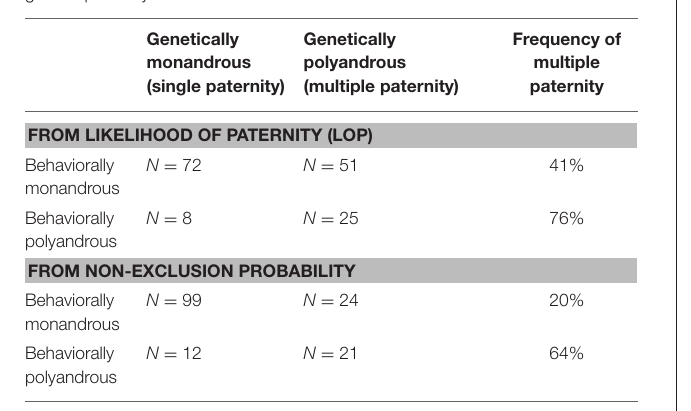
TABLE 2 | Comparison of the number of sexual partners inferred for each white-tailed prairie dog female and her litter from observations of copulations and genetic paternity.